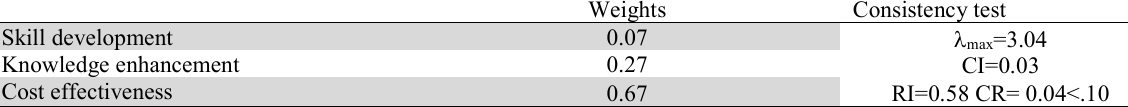
Weights Consistency test